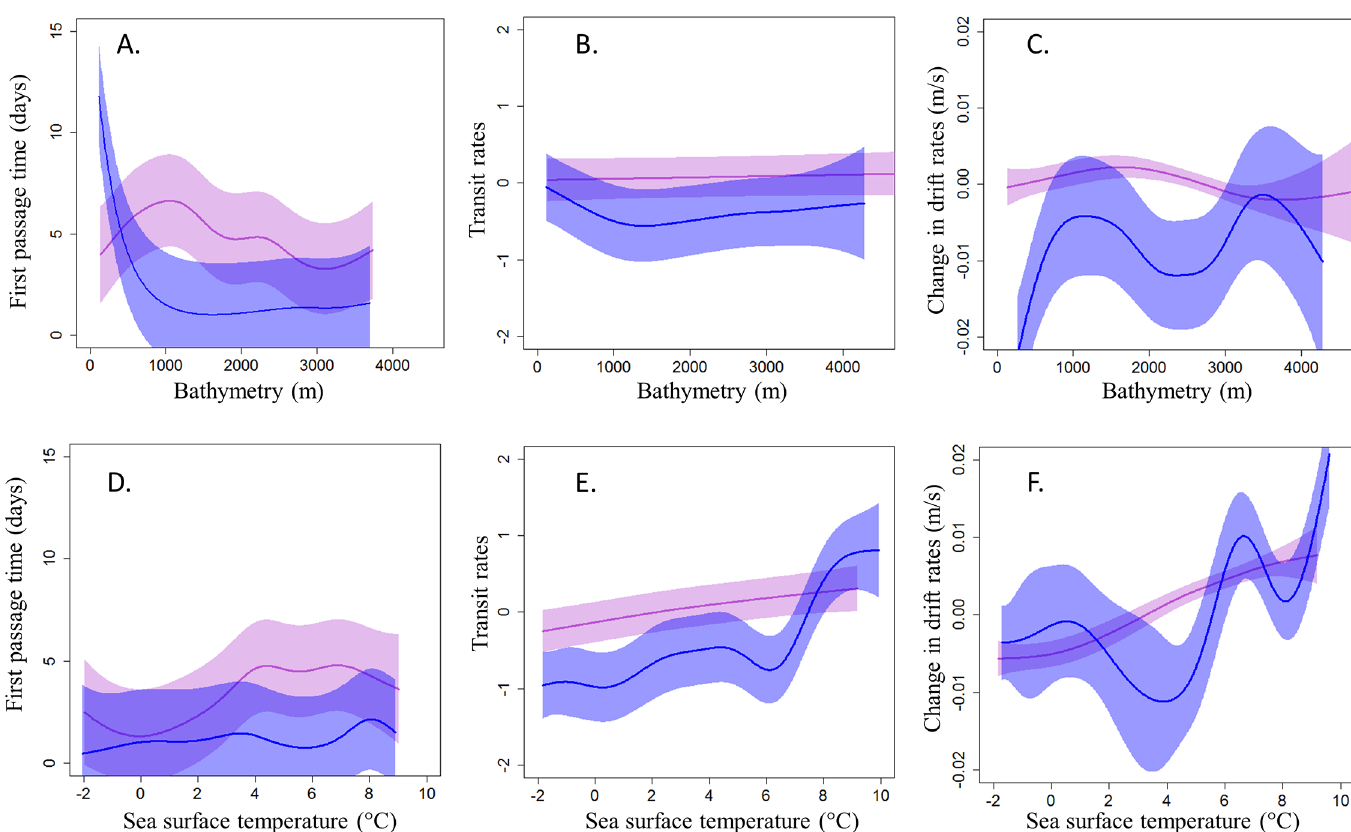
Fig 3. Effect of bathymetry and SST on foraging indexes of hooded seals using (A) first passage time (days), (B) vertical transit rates when diving (PCA derived combination of ascent and descent rates, no unit), and (C) change in drift rates (m/s), for pups (purple) and adult male (blue) hooded seals during the post-molting season. Fitted estimates from best models (solid curves) are representedalong with the CIs (polygons) calculatedfrom the variance–covariancematrices of the randomeffects of the fitted models.